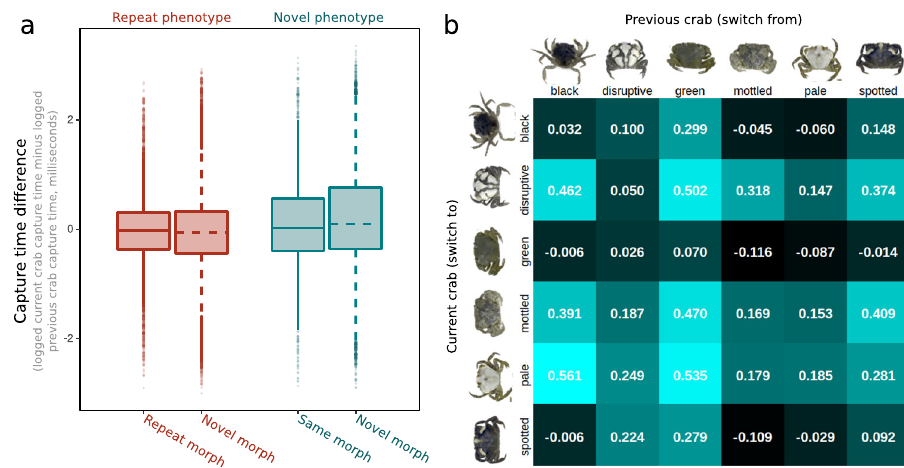
Fig. 5 Plots showing the effects of switching between phenotypes and morphs of different types. a Boxplots of raw data, showing the capture time interaction between repeat/novel crabs and repeat/novel morphs. When participants switched to both a new crab and a new morph, capture times were signi fi cantly increased. Boxes show interquartile ranges, points show outliers, based on 33,208 observations from 1746 participants. b Figure showing how each morph switch affected sequential capture times (i.e. current crab capture time minus previous crab capture time, logged ms). Positive numbers (cyan) show that the current morph is more dif fi cult to fi nd than the previous morph, and negative numbers (black) show that the current morph is easier to fi nd than the previous